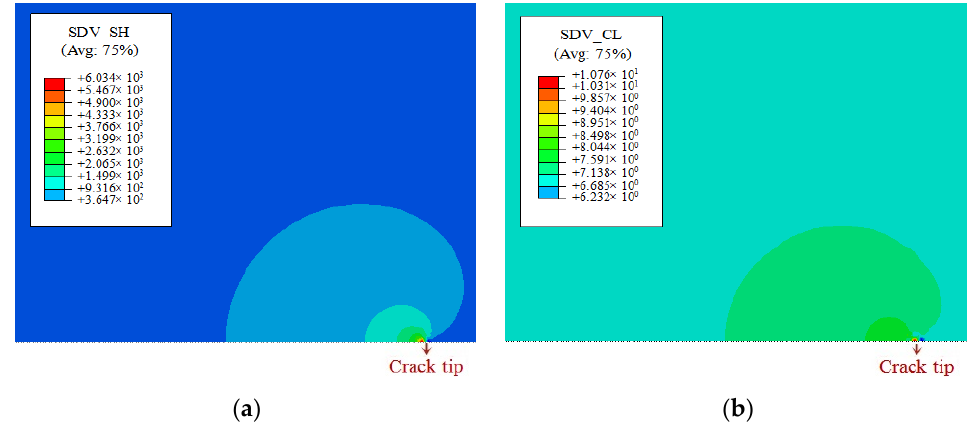
Figure 9. ( a ) Hydrostatic stress and ( b ) hydrogen concentration contours near the crack tip at u = 0.214 mm for 0 C = 7.0 ppm.